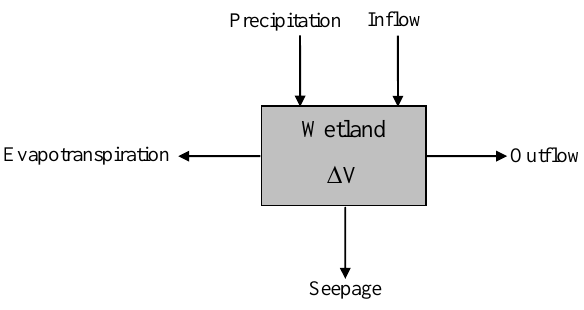
Fig. 4. A schematic diagram of the hydrological processes in the Zalong Wetland, Northeast China.